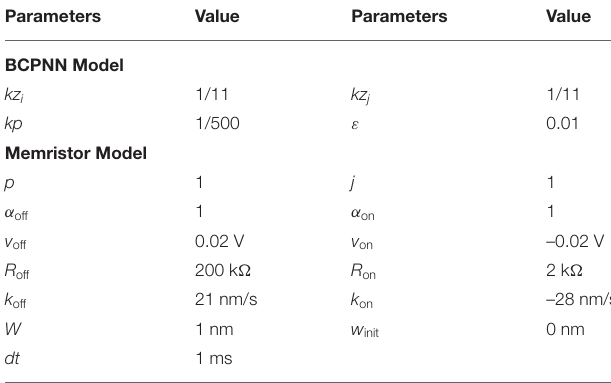
TABLE 1 | Parameters for the